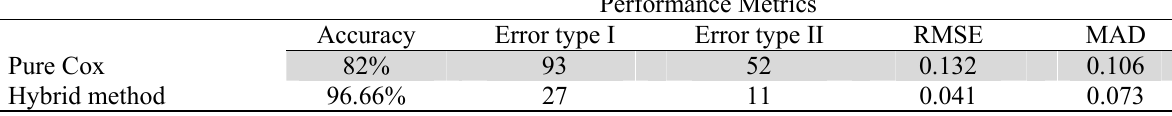
The results of comparing the performance of Pure Cox and Hybrid